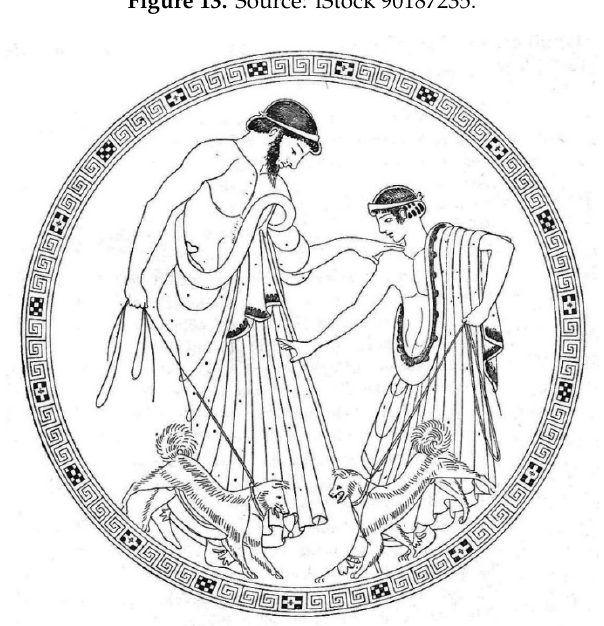
Figure 13. Source: iStock 90187235.